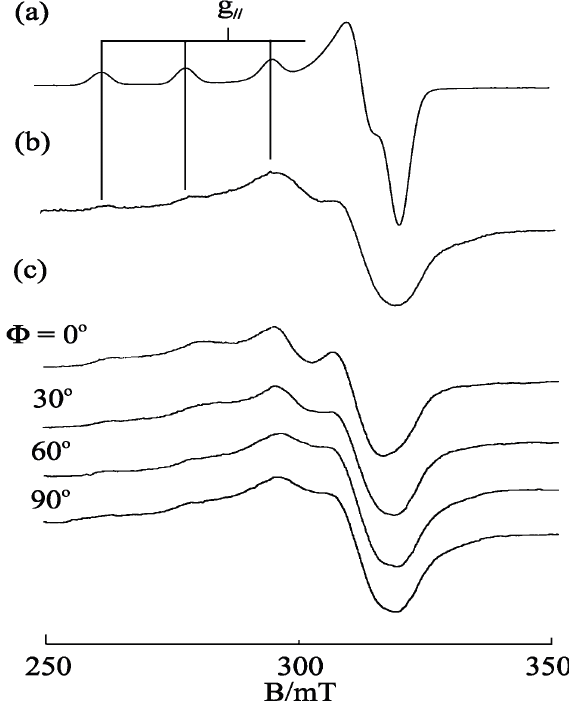
Figure 13. EPR spectra of [Cu(phen)(edda)] ( a ) in frozen solution at − 150 °C; ( b ) in DNA-pellet at − 150 °C; and ( c ) in A-form DNA fiber at room temperature. Ф is the angle between the fiber axis and the static magnetic field